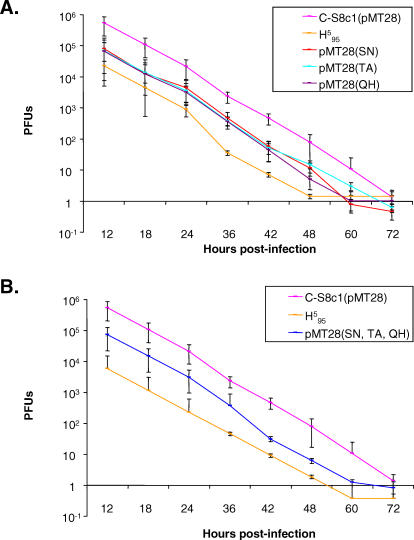
Killing of BHK-21 Cells by FMDV MutantsTime needed to kill 104 BHK-21 cells as a function of the initial number of PFU of the following viruses:(A) C-S8c1(pMT28),
, pMT28 (SN), pMT28 (TA), and pMT28 (QH).
(B) C-S8c1(pMT28),
, and pMT28 (SN, TA, QH).
Each value represents the mean and standard deviation from triplicate assays. The viruses analyzed are described in Materials and Methods. Virulence values are given in Tables 2 and S1.